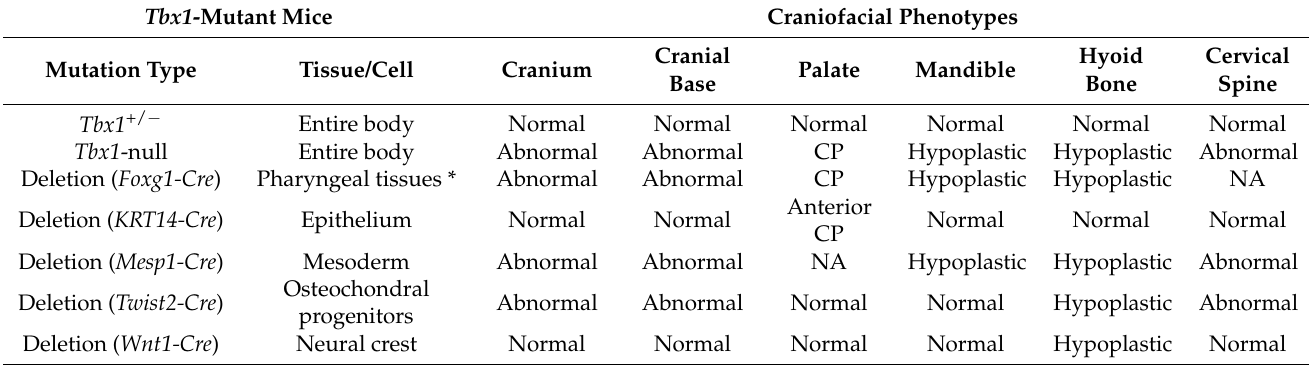
Table 5. Selected craniofacial phenotypes of Tbx1 -mutant